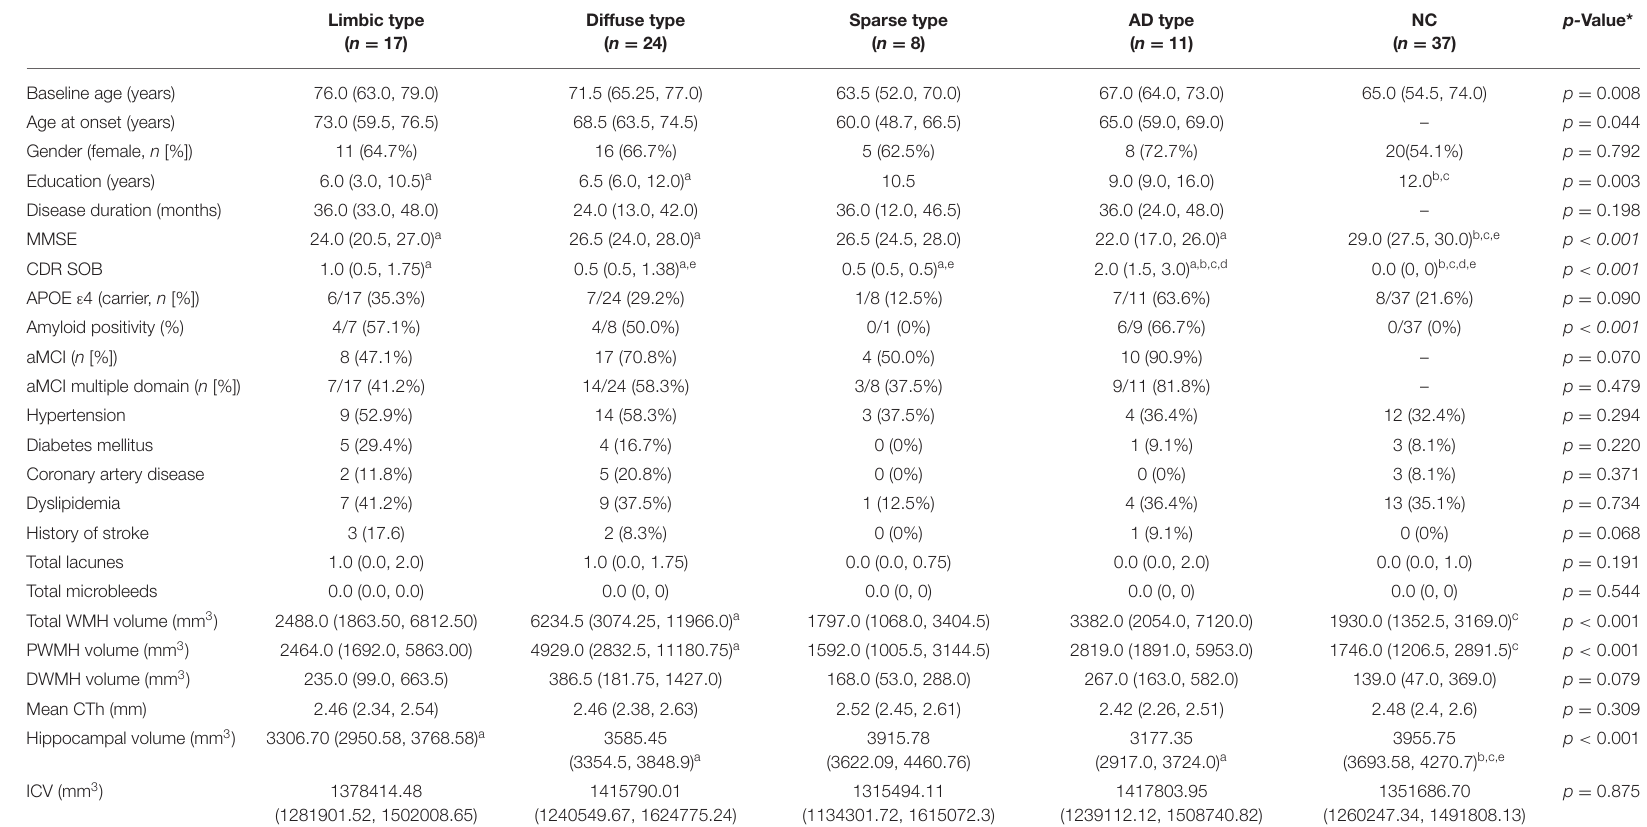
TABLE 2 | Demographics and clinical characteristics of the study